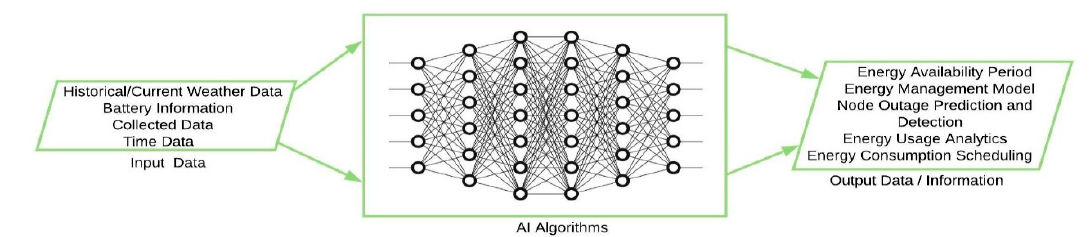
Figure 5. Some input data and their potential usage with AI algorithms.